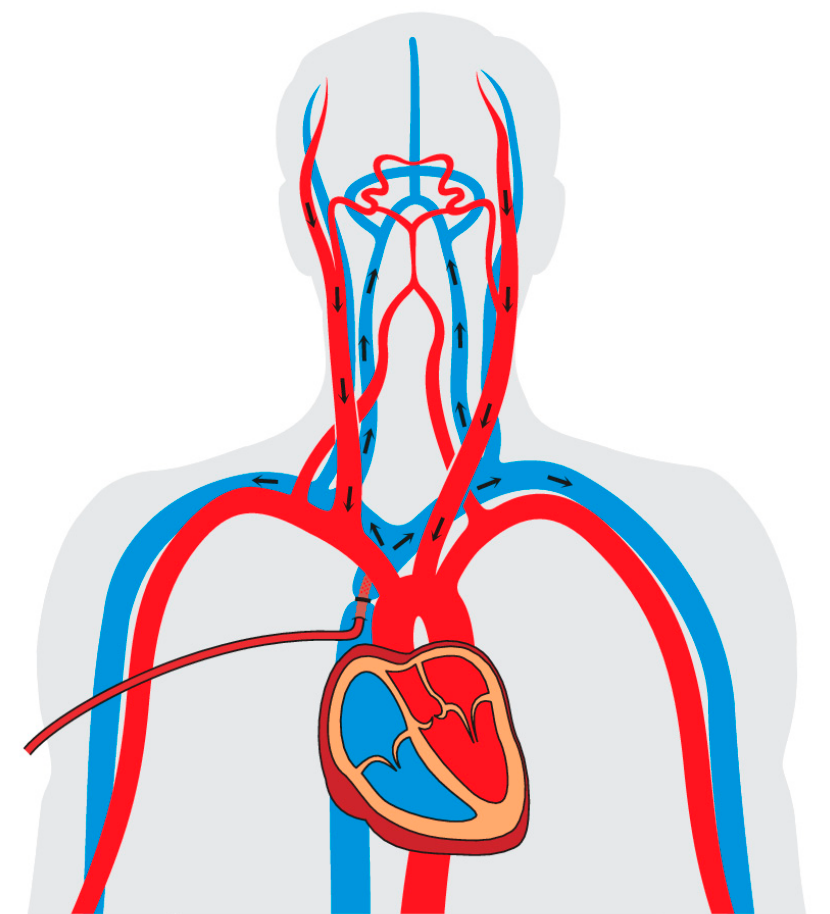
Figure 2. Performance of retrograde cerebral perfusion.